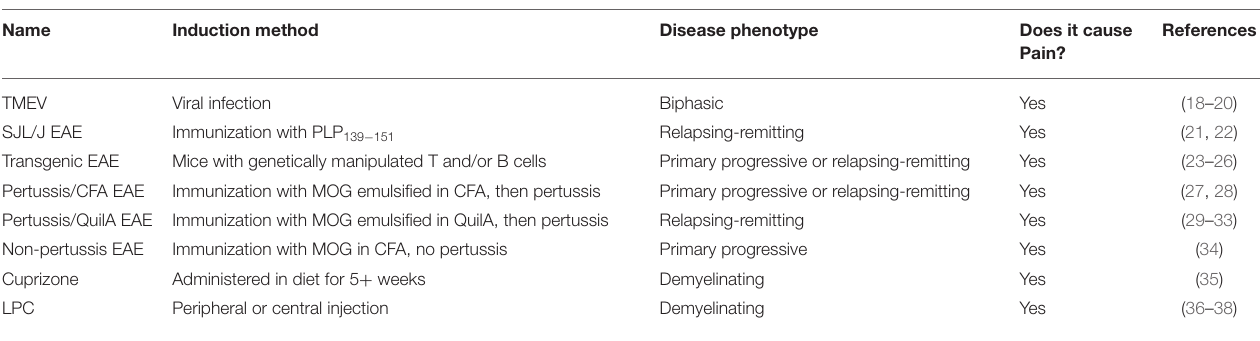
TABLE 1 | Mouse models of Multiple